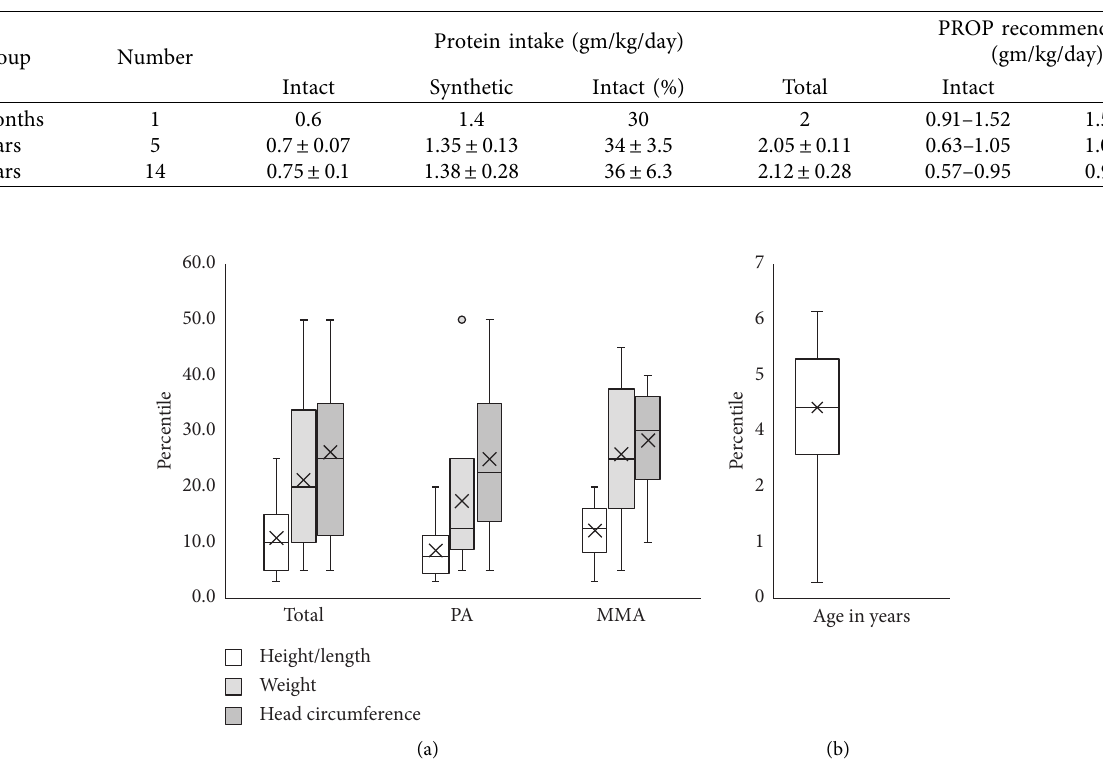
Figure 1: Daily protein intake (gm/kg/day), both intact and synthetic in each individual patient. Patients are categorized by age and diagnosis. The percentage of natural protein intake in all patients was lower than the protein provided through the amino acid formula, 35.23 ± 5.7%, with a range of 24%–45%. Table 3: Observed daily protein intake.